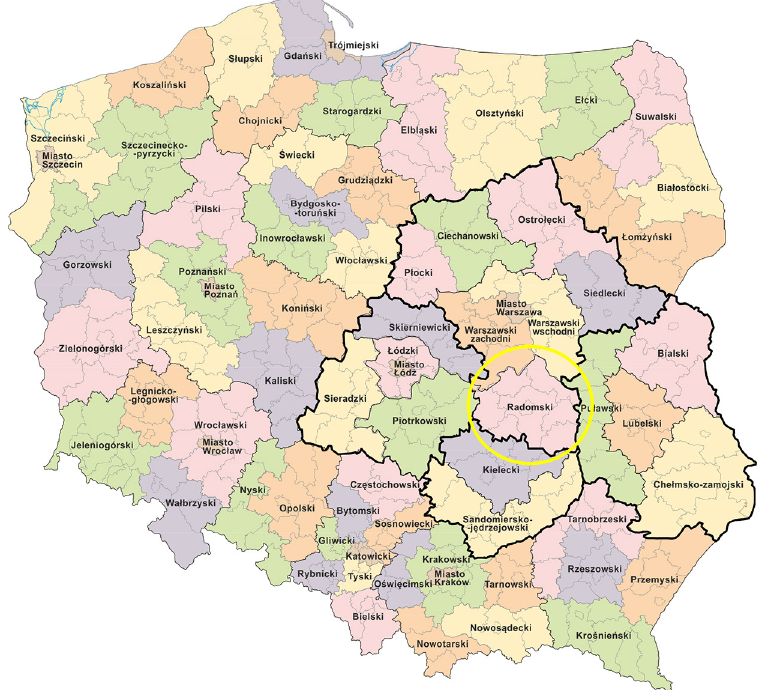
Fig. 2. Research area. Radom subregion is marked in a yellow circle. Source: own